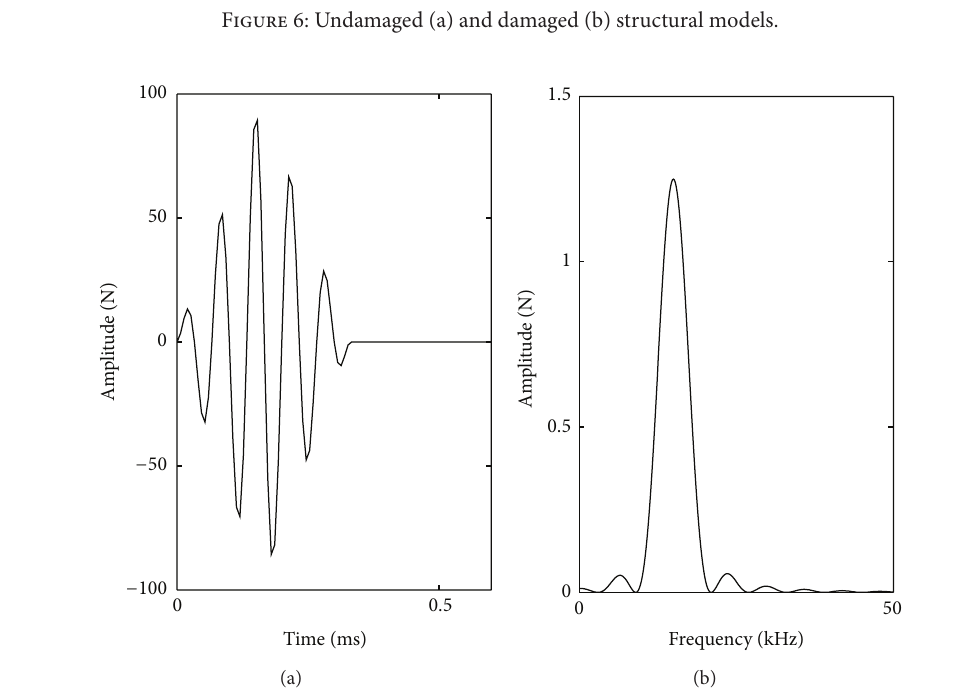
Figure 7: Time (a) and frequency (b) representations of tone-burst force excitation signal at 𝑓 = 15 kHz with 5